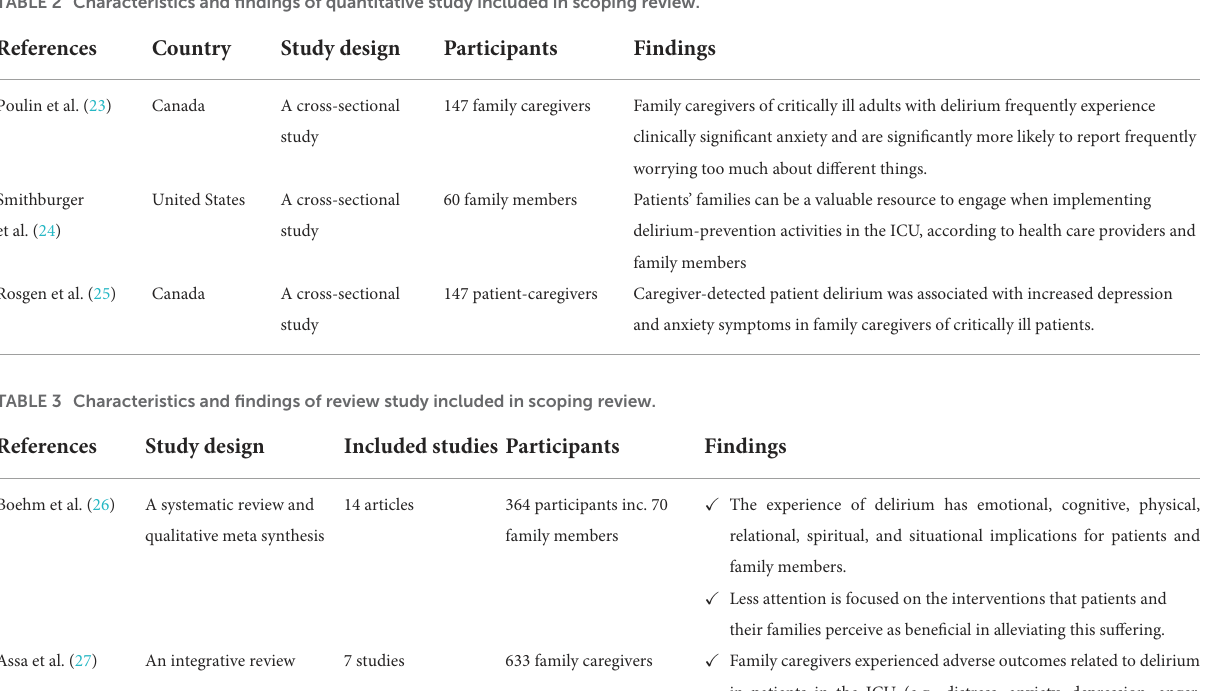
TABLE 2 Characteristics and findings of quantitative study included in scoping review.